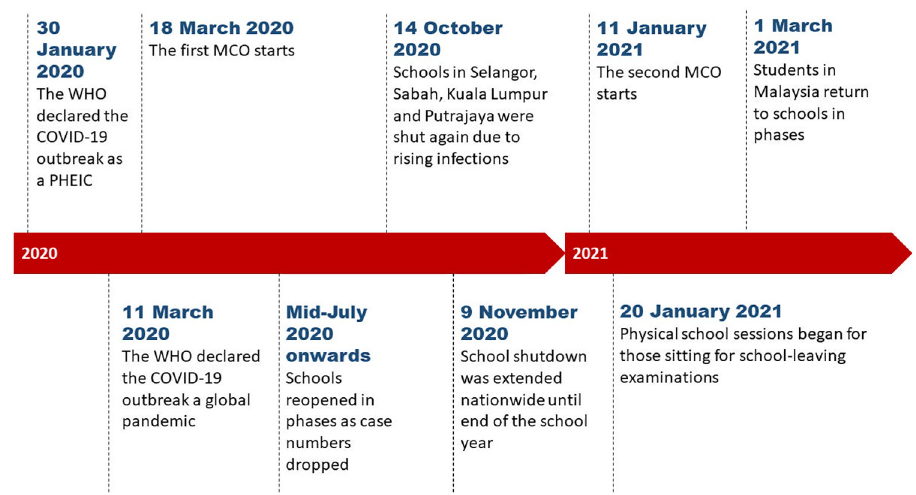
Fig 1. Timeline of school closures and reopenings in Malaysia during the COVID-19 pandemic from January 2020 until March 2021. WHO—World Health Organization; MCO—Movement Control Order; PHEIC—Public Health Emergency of International Concern. Sourced from [22, 23,